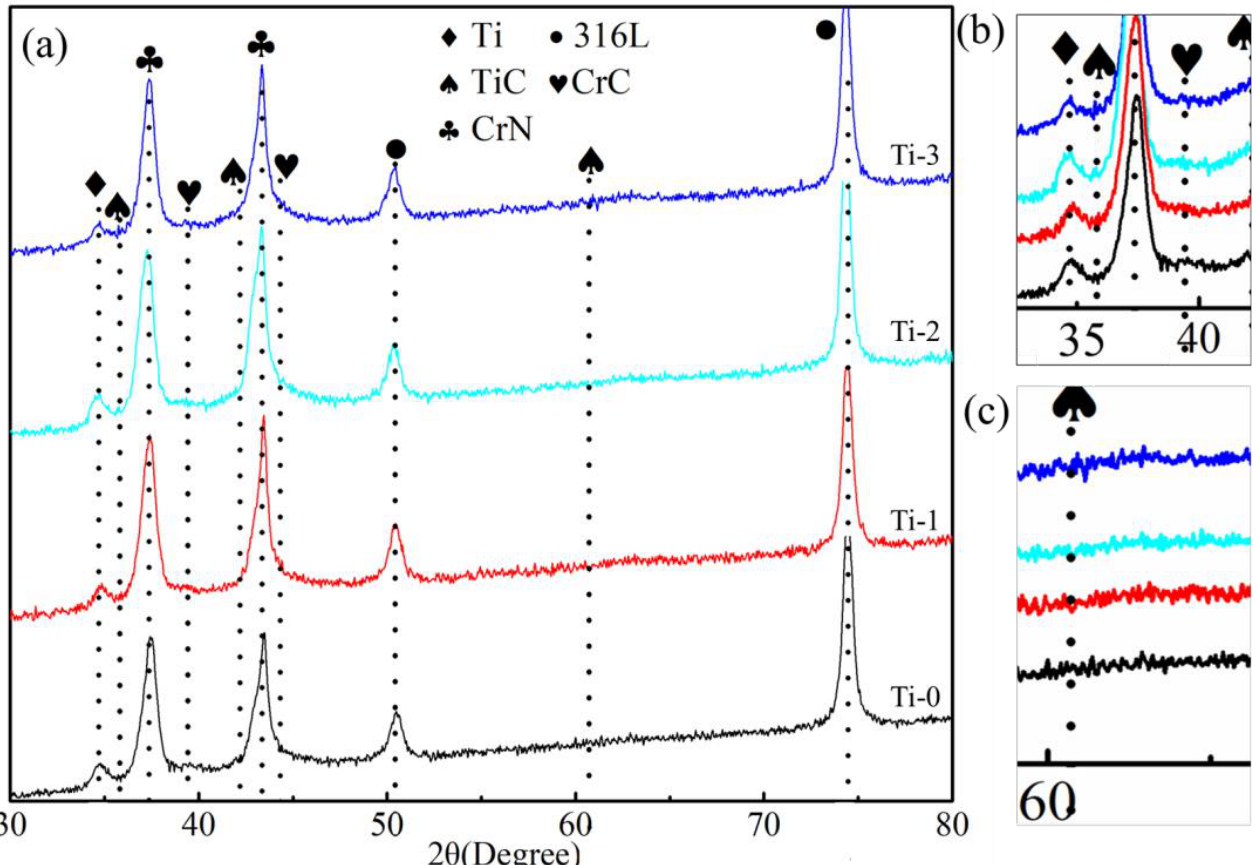
Figure 4. XRD analysis results for all coated specimens: ( a ) XRD spectrum, ( b , c ) partial enlarged view of TiC.